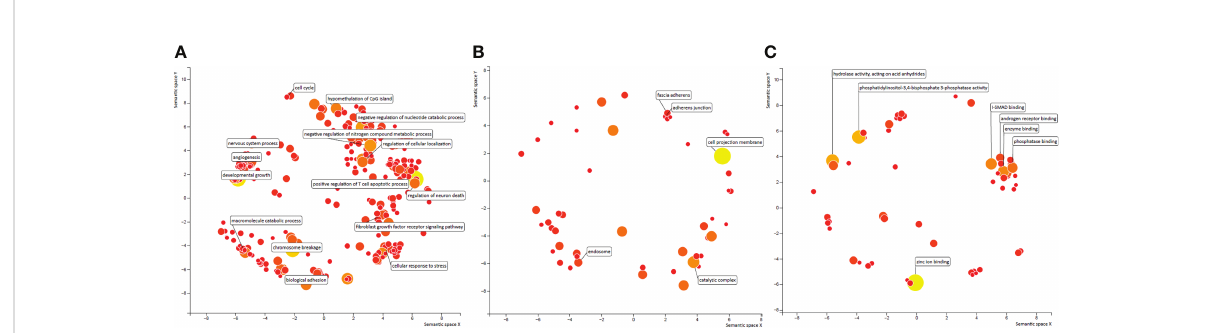
FIGURE 11 (A) GO term clustering of Biological Process identi fi ed by only one of the four algorithms. The distance between two GO terms were inferred based on pair-wise semantic similarities. (B) GO term clustering of Cellular Component identi fi ed by only one of the four algorithms. The distance between two GO terms were inferred based on pair-wise semantic similarities. (C) GO term clustering of Molecular Function identi fi ed by only one of the four algorithms. The distance between two GO terms were inferred based on pair-wise semantic